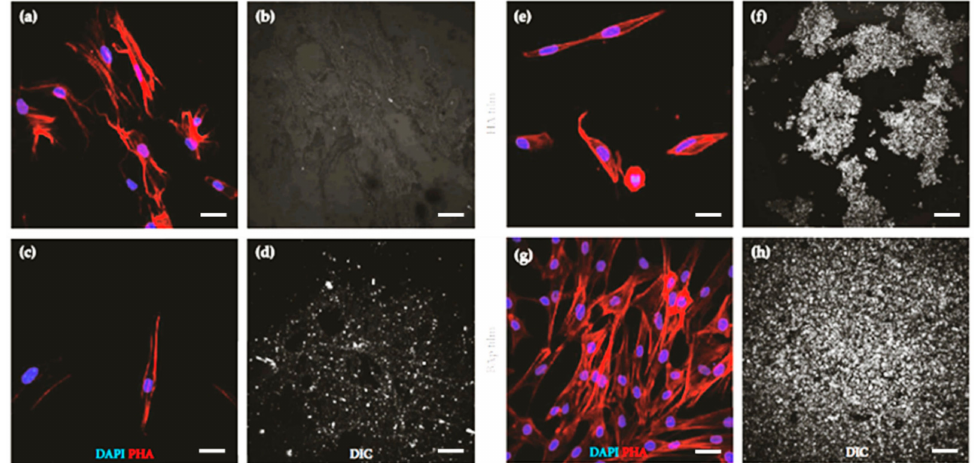
Figure 7. Immunofluorescence images ( a , c , e , g ) showing cell morphology of hDPSCs cultured on HA and BAL films and di ff erential interface contrast microscopy images ( b , d , f , h ) representing film adhesion to the underlying surface at 7 days of culturing. Immunofluorescence analysis was performed against phalloidin (PHA). Nuclei were counterstained with 4’,6-diamidino-2-phenylindole (DAPI). Scale bar is 10 µ m